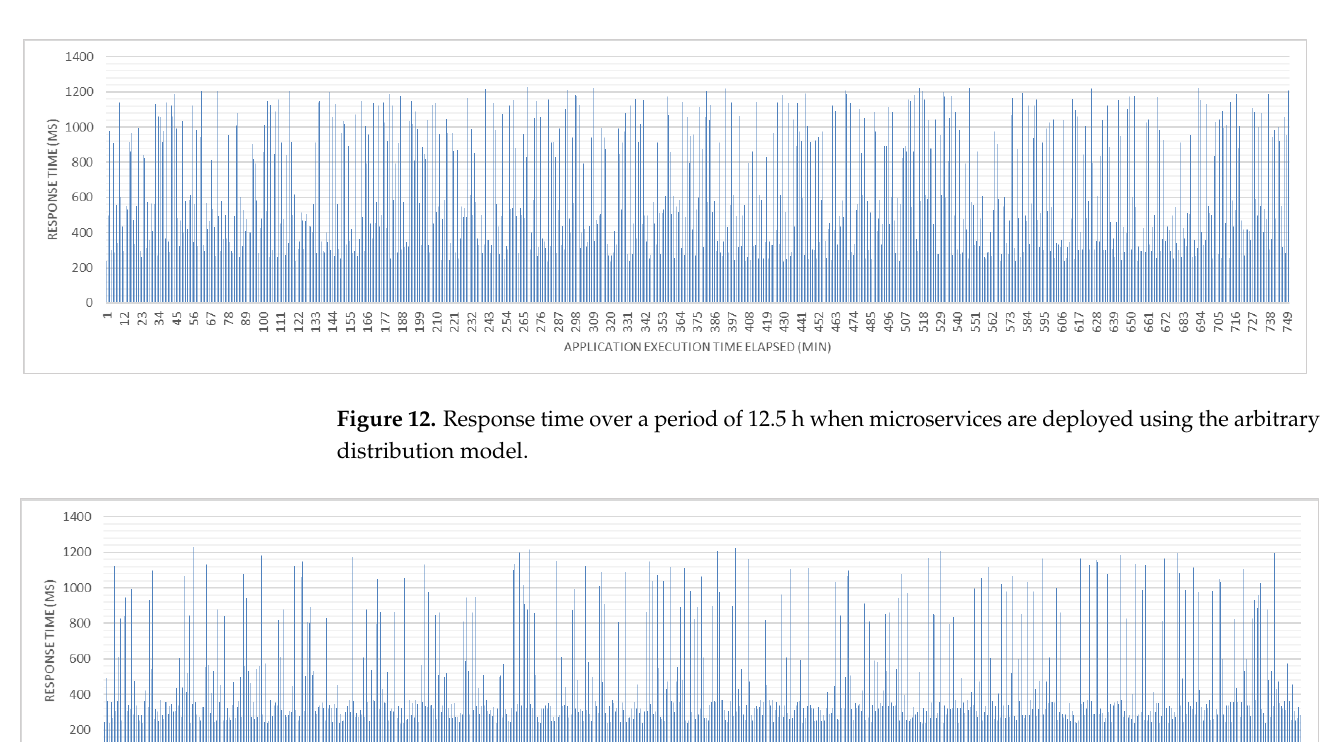
Figure 13. Response time over a period of 12.5 h when microservices were deployed using the design-pattern distribution.